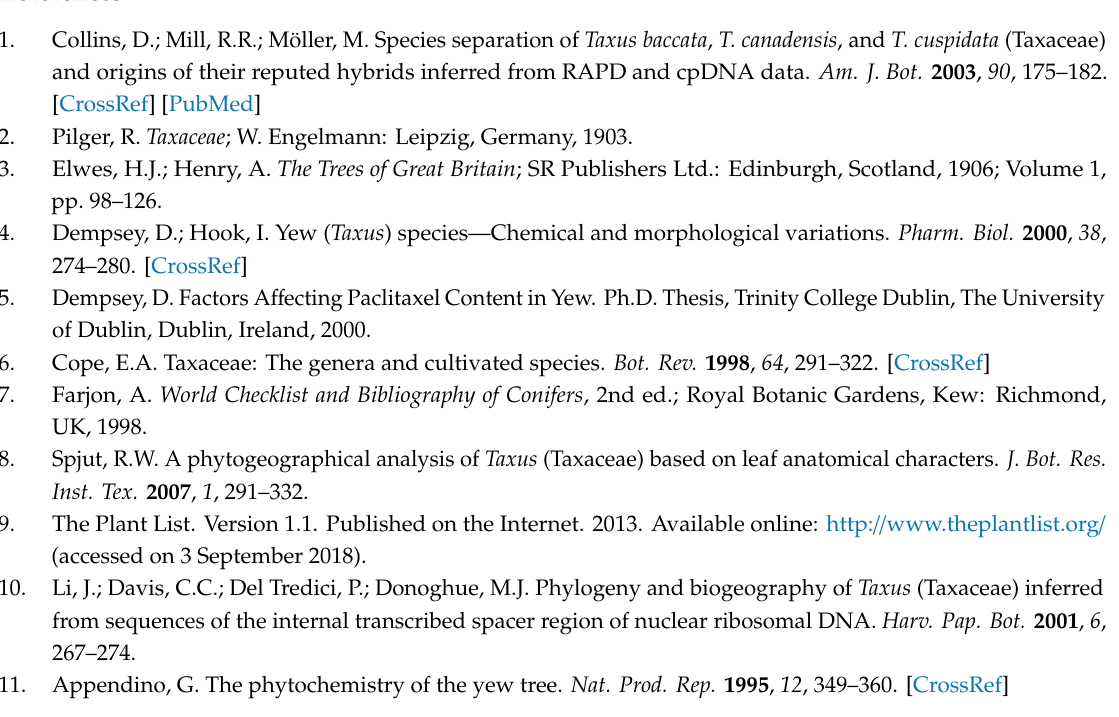
Figure S1: Bayesian inference phylogenetic reconstruction of Taxaceae based on trnL and trnL-F plastid DNA Figure S2: Maximum likelihood phylogenetic reconstruction of Taxaceae based on trnL and trnL-F plastid DNA, Figure S3: Bayesian analysis of trnL-F data including Taxus and Pseudotaxus only, Figure S4: ML bootstrap consensus tree of nrITS sequence data for Taxus and Pseudotaxus only, Figure S5: Bayesian analysis of nr I TS sequence data for Taxus and Pseudotaxus only, Figure S6: trnL intron and trnL-F haplotype TCS analysis, Figure S7: Leaf anatomy of Taxus . Table S1a,b: Sequences used from GenBank for a) nrITS and b) trnL-F , Table S2: Leaf anatomy data for Taxus